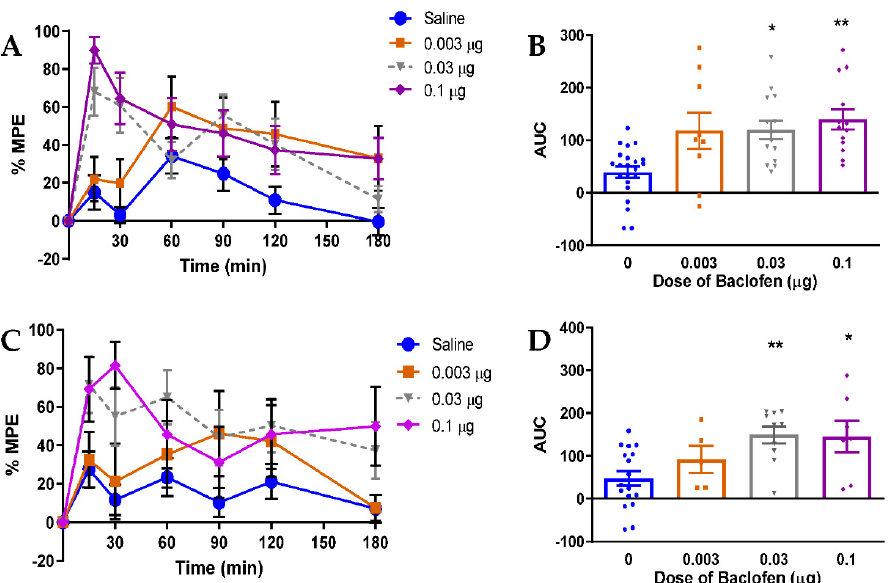
Figure 4. Effect of baclofen on tactile allodynia in 4- and 8-week diabetic rats. ( A ) % MPE of tactile allodynia over the 3 h following IT baclofen administration in 4-week diabetic rats. ( B ) Tactile allodynia dose-response AUC in 4-week diabetic rats following IT baclofen (0.003–0.1 µ g) injection. ( C ) % MPE of tactile allodynia over the 3 h following IT baclofen administration in 8-week diabetic rats. ( D ) Tactile allodynia dose-response AUC in 8-week diabetic rats following IT baclofen (0.003–0.1 µ g) injection. Tactile withdrawal threshold was assessed at 0, 15, 30, 60, 90, 120, and 180 min after injection. AUC was calculated using the trapezoidal method. * p < 0.05, ** p < 0.01 compared to saline (‘0 (cid:48) ) by one-way ANOVA followed by Dunnett’s post-hoc test. n =